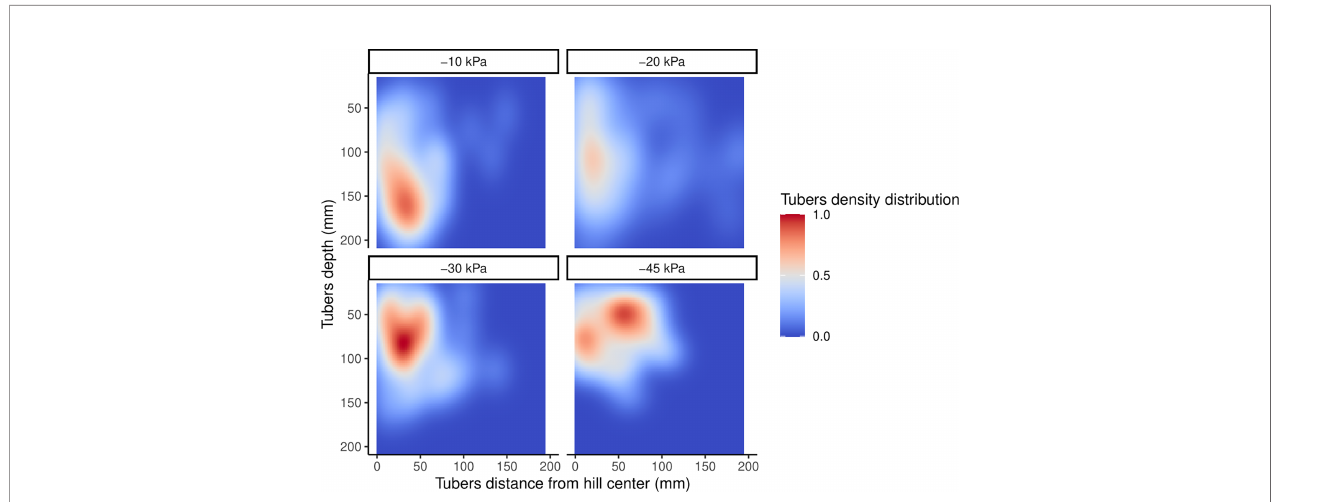
FIGURE 6 | Two – dimensional (2D) kernel depicting the tubers probability density distribution under the four SMPT treatments ( − 10, − 20, − 30, and − 45 kPa). The Y axis shows the vertical distribution of the tubers and the X axis relates to the tubers distance from the center of the top of the potato